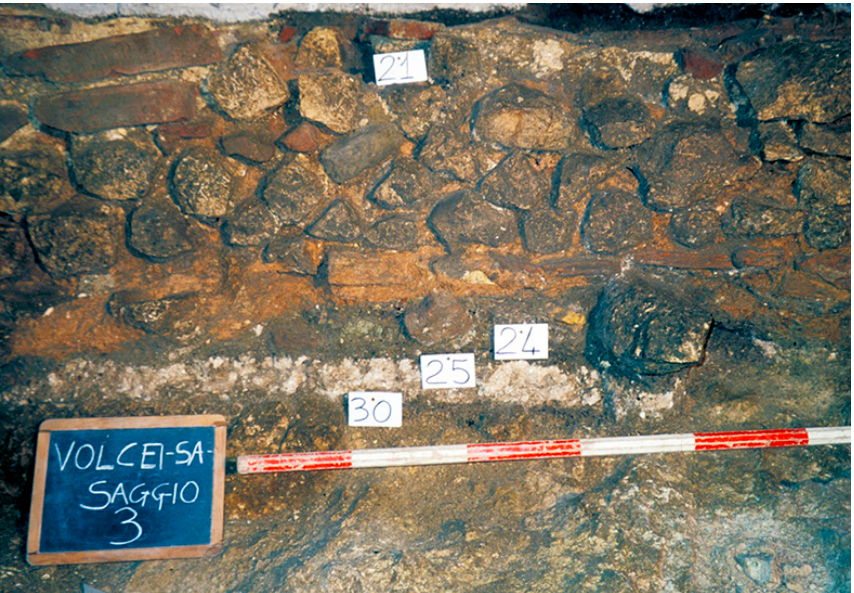
Figure 4. Simultaneous collapse of the incannucciato ceiling (unit 24) and of the plaster (25) over the mortar floor (30) of the inhabited room. Unit 21 is instead the foundation of a medieval wall that was carved within the Roman rubble. For the record, this medieval wall collapsed due to a further earthquake, and its relics were found inside an adjacent room (photo by P.G.).